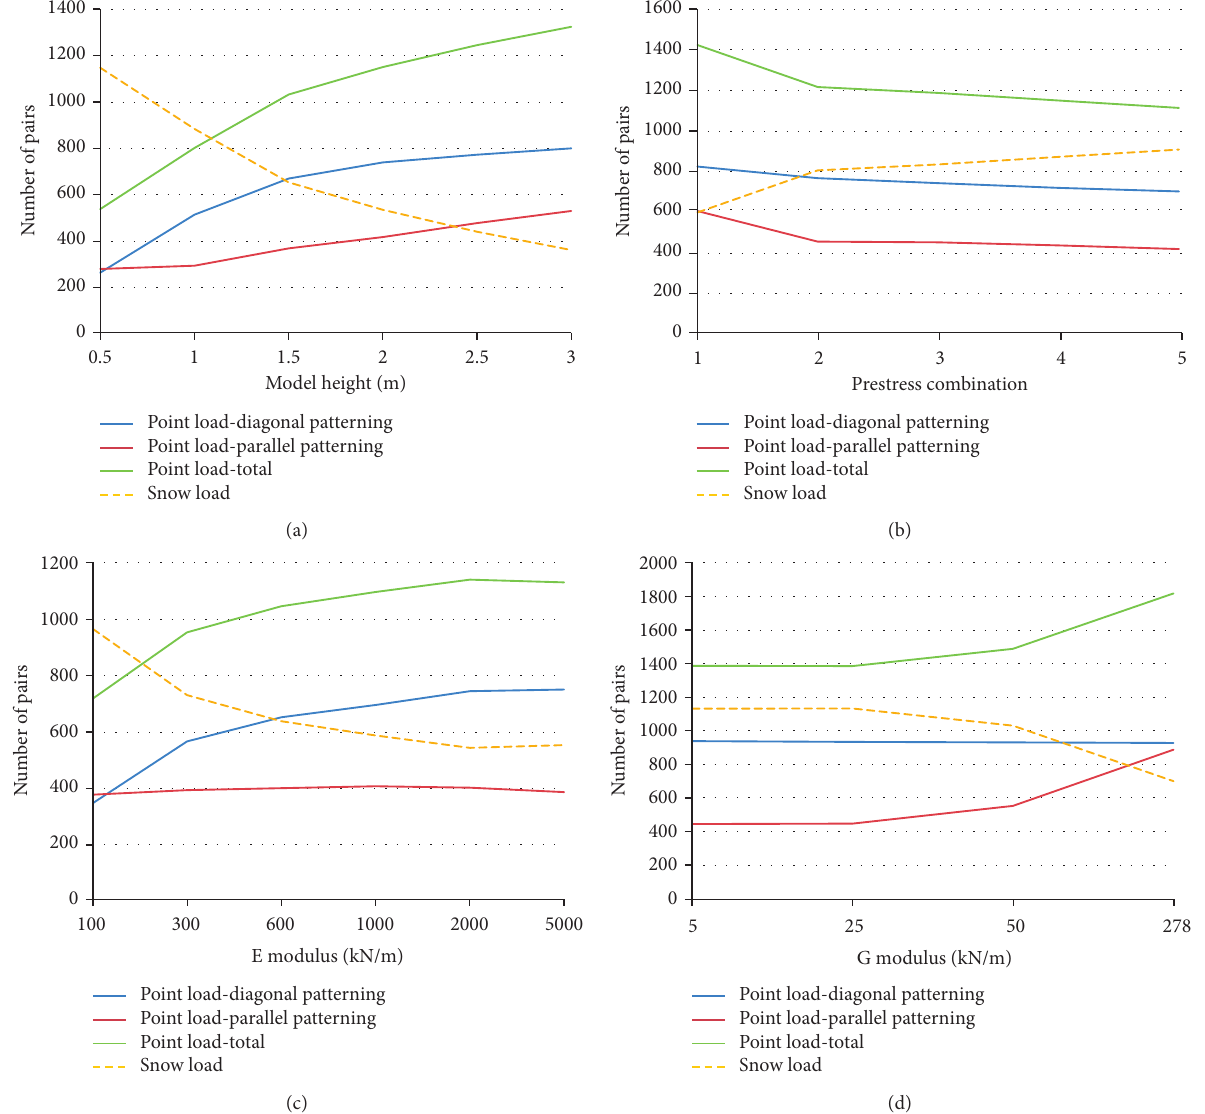
Figure 9: Number of pairs with larger deflections under point or snow load depending on the following parameters. (a) Model height. (b) Prestress combination. (c) E modulus. (d) G